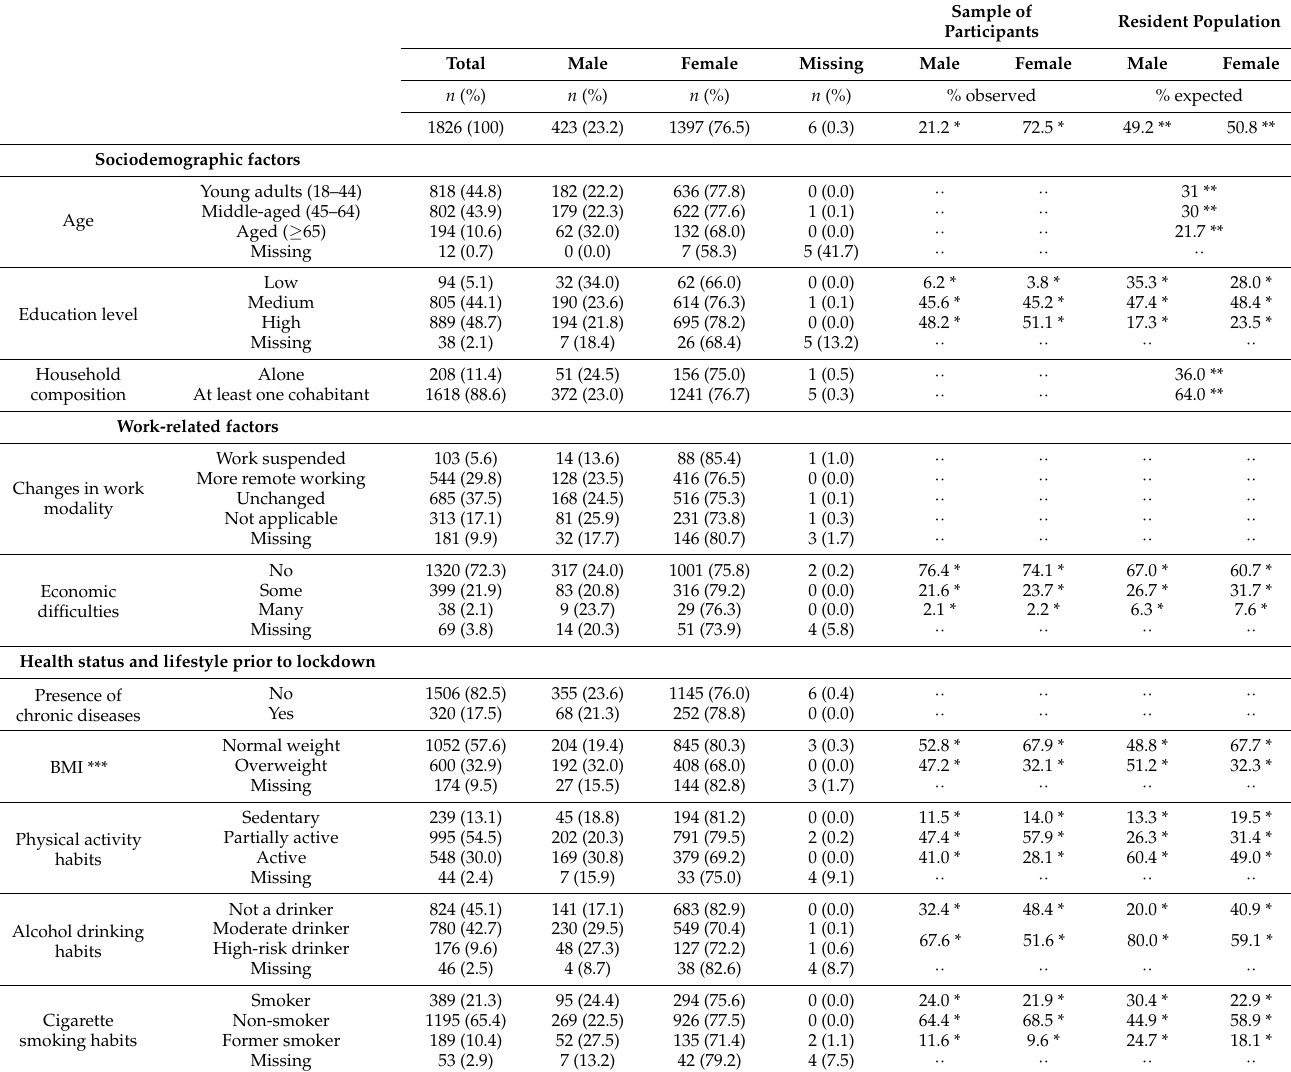
Table 1. Descriptive analysis of participants by sex: sociodemographic factors, work-related factors, health status, and lifestyle prior to